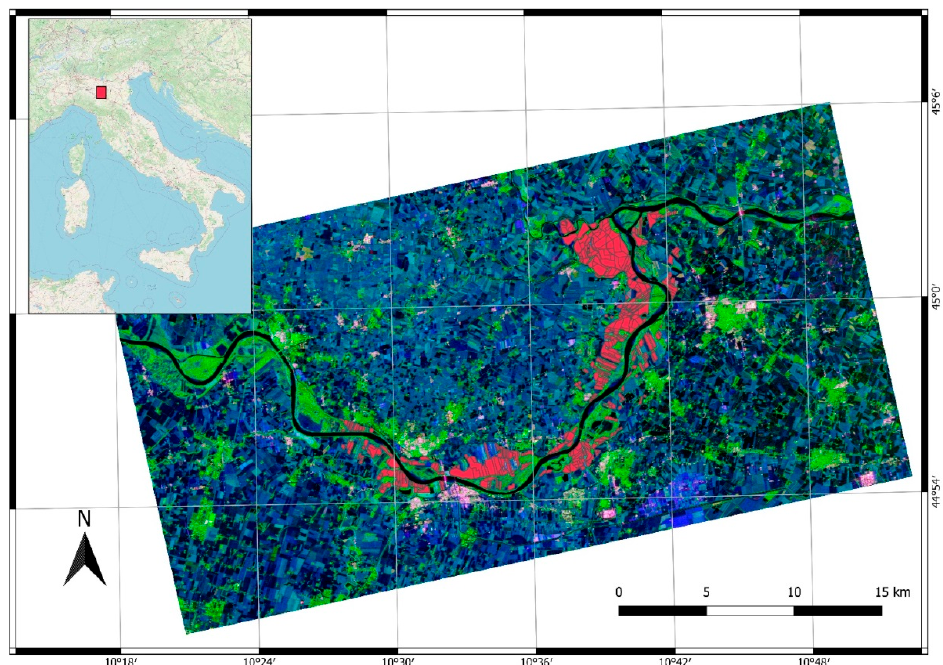
Figure 1. In the upper left box, the location of the study area in the Italian Po valley is shown. The main image is a RGB color composite obtained using the Yamaguchi decomposition of the quad-pol ALOS2 SAR scene (R: surface scattering: G: volumetric scattering; B: double bounce). The poplar stands used as ground truth in the classification models are evidenced in red.